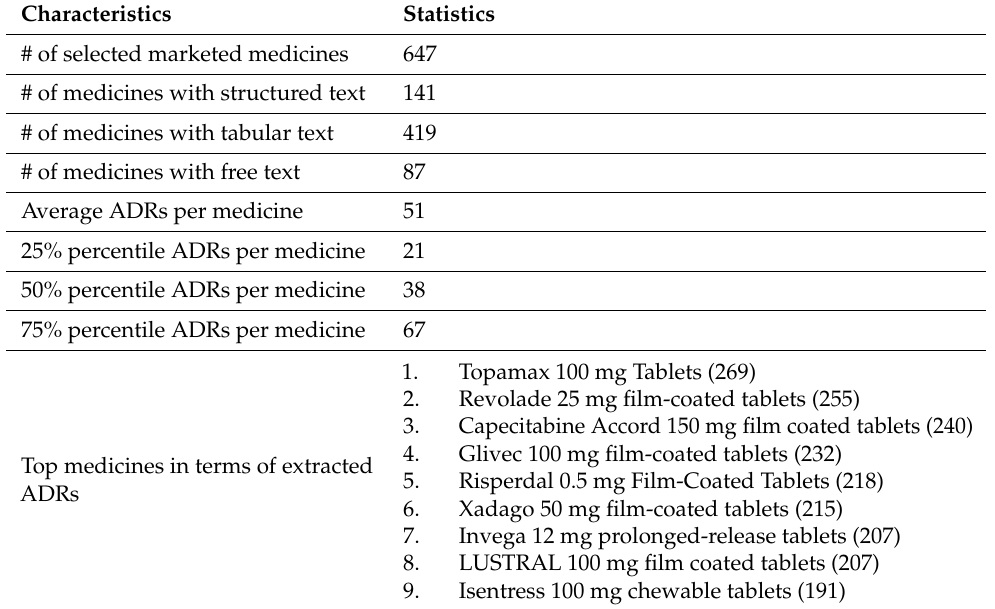
Table 2. Overview of the ADR extraction